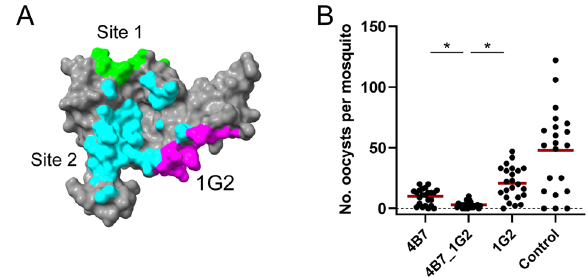
Fig. 6 Mapping of 1G2 and other reported transmission-blocking mAbs and enhanced TRA with mAb combination. The mAb 1G2 epitope (magenta) is shown in context to other transmission- blocking regions identi fi ed as Site 1 (green) and Site 2 (cyan) 14,15 , respectively. ( A ). Site 1 overlaps with the binding site of mAb 4B7 14 . The combination of mAbs 1G2 and 4B7 shows enhanced TRA compared to each alone ( B ). The average TRA (reduction of oocyst density) was 81.6% (4B7 alone), 60.6% (1G2 alone), and 94.6% (combination of 4B7 and 1G2) at 158 µg/mL, 149 µg/mL, or 158/ 149 µg/mL, respectively, compared to the control (mAb 48F8 at 321 µg/mL). A comparison of the TRA between 4B7 or 1G2 with 4B7 and 1G2 in combination, showed signi fi cant differences (*, p < 0.001) using a zero-in fl ated negative binomial model with an interaction term. P-values are from post-hoc linear